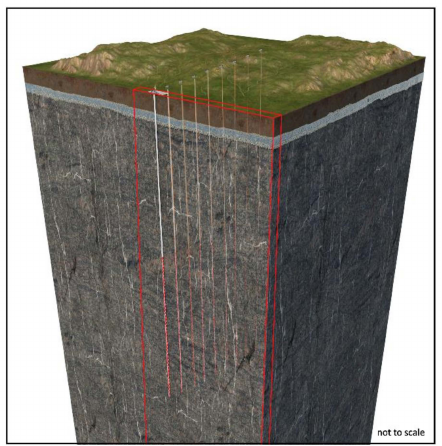
Figure 1. Schematic of a deep vertical borehole repository (not to scale). The repository consists of multiple, parallel boreholes drilled vertically into crystalline bedrock, each accommodating 200 canisters containing a single fuel assembly from a pressurized water reactor. The waste emplacement section is between a depth of 1.5 and 3 km. The red box indicates the modeled symmetry cell. The borehole diameter is